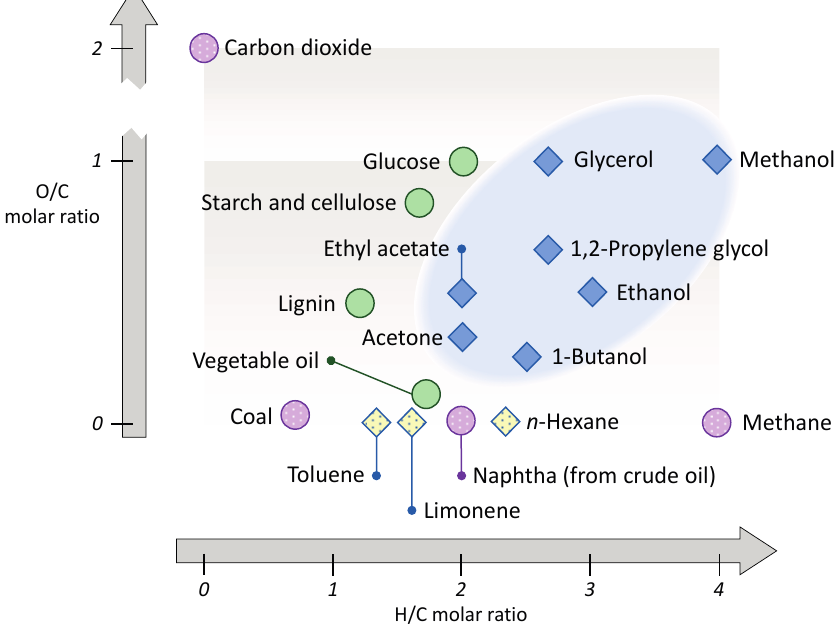
Figure 5. Chemical composition map of fossil derived resources (spotted circles), biomass feedstocks (solid circles) and representative organic solvents (hydrocarbons as spotted diamonds, oxygenated solvents as solid